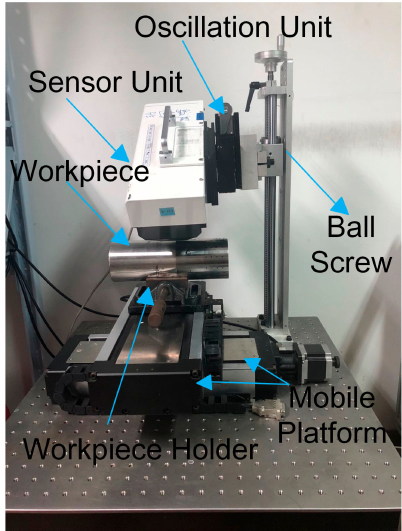
Figure 6. The X-ray residual stress analyzer.